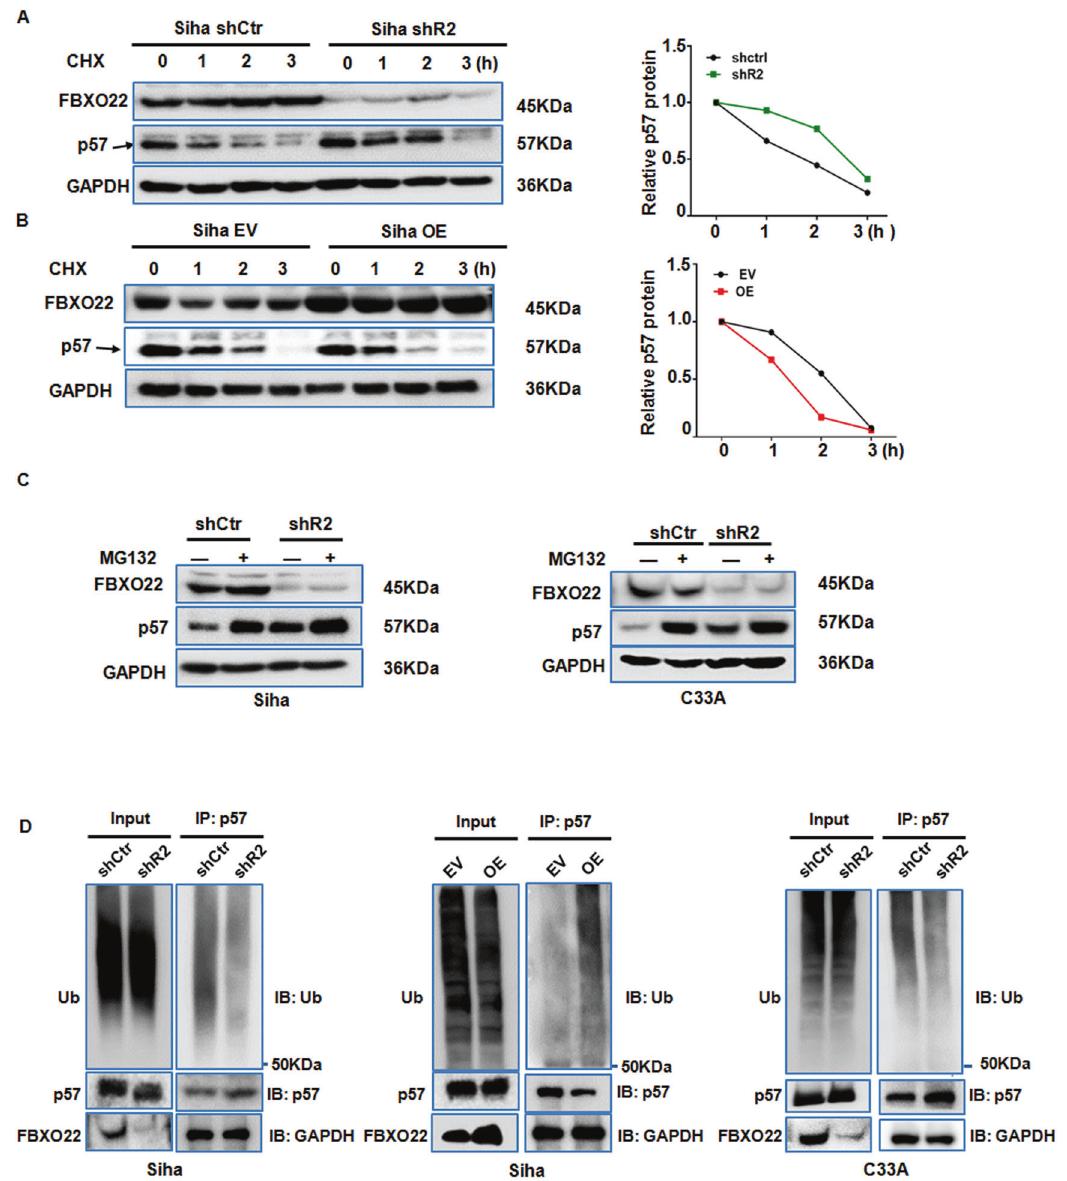
Fig. 6 FBXO22 regulates the ubiquitination and degradation of p57Kip2 protein. A , B SiHa cells with FBXO22 knockdown ( A ) or overexpression ( B ) were treated with cycloheximide (CHX) at 100 μ M, and then harvested at the indicated time points. The cell lysate was analyzed by the Western blotting for FBXO22, p57Kip2, and GAPDH levels (left panel). Quanti fi cation of the p57 levels relative to GAPDH expression is also shown (right panel). C Western blotting was used to detect the changes of p57Kip2 protein in SiHa and C33A cells without or with FBXO22 knockdown before and after MG132 (20 μ M) treatment. D The levels of ubiquitinated p57Kip2 was measured in immunoprecipitated p57Kip2 in the CC cells with FBXO22 knockdown or or without (migration) growth factor-reduced Matrigel ((BD Biosciences, NJ, according to the manufacturer ’ s protocol. The supernatant containing 6 μ g USA). 4 × 10 4 SiHa cells or 7 × 10 4 C33A cells in the medium without the FBS protein was mixed with 120 μ L immunoreaction reagent (including anti- were seeded in the upper chamber for the migration assay. In the same DNA-POD, anti-histone biotin) and incubation buffer at 1:1:18 volume chamber, 6× 10 4 SiHa cells or 8 × 10 4 C33A cells were plated into the FBS- ration and added to a Streptavidin-coated 96-well plate and incubated on free medium for the invasion assay. Growth medium containing 10% FBS a shaker at 200 rpm for 2 h in the dark at room temperature. The solution was used as a chemoattractant in the lower chamber. After indicated times was carefully removed and a 100 μ L substrate buffer was added. The plate (16 h for SiHa cell and 20h for C33A cell), migrated and invaded cells were was incubated on a shaker at 200 rpm for a few min at dark at room fi xed in the membrane using 90% methanol and stained with 0.1% crystal temperature until color changes to dark green. Finally, the OD values at violet. The cotton cells in the upper chamber were removed gently. Cells 405 nm and 490 nm were, respectively, detected and the apoptotic index were counted under an inverted microscope at ×200 magni fi cation. was calculated. Each experiment was repeated three times. Migration and invasion assays Western blot analysis Migration and invasion assays were performed using the Transwell SiHa and C33A cells were lysed in a lysis buffer (50 mM Tris-HCl pH 7.4, chambers (8.0 μ m pore size with polycarbonate membranes) with (invasion) 150 mM NaCl, and 0.5% NP-40) containing protease and phosphatase